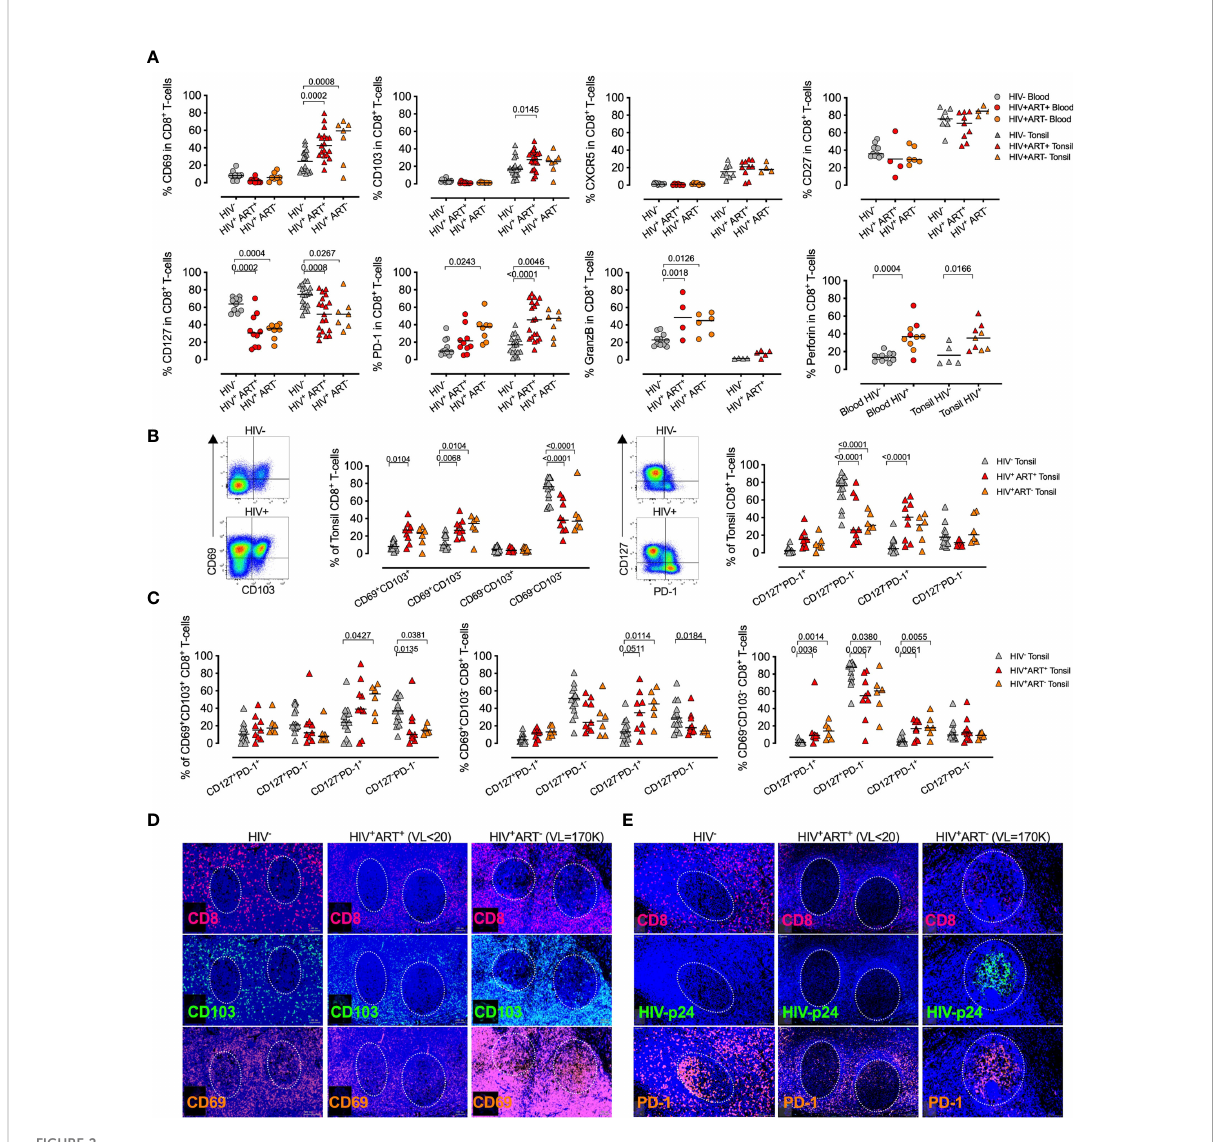
FIGURE 2 Treated HIV infection drives a tissue resident memory CD8 + T-cell phenotype with high PD-1 expression and distinct in situ tissue locations within HIV infected tonsils. (A) Percentage of blood ( n= 29, circles) and tonsil ( n= 44, triangles) CD8 + T-cells expressing CD69, CD103, CXCR5, CD27, CD127, PD-1, GZMB and perforin markers between HIV - (grey), HIV + ART + (red) and HIV + ART - (orange). P-values were calculated using ordinary one-way ANOVA with horizontal bars representing median values with the level of signi fi cance indicated with p-value. (B) Representative FACS plot of CD8 + T-cells from HIV - (grey) and HIV + ART + (red) HIV + ART - (orange) tonsils ( n= 29) for co-expression of CD69/CD103 and PD-1/CD127 with cumulative data shown with horizontal bars representing median values and p-values by Kruskal-wallis multiple comparisons. (C) CD127/PD-1 co- expression on indicated CD69/CD103 CD8+ T-cell subsets. (D) CD8, CD69, CD103 fl uorescence immunohistochemistry of whole tonsil sections zoomed in at individual GCs for three independent donors from HIV - (left), HIV + ART + (middle) and HIV + ART - (right) with individual markers shown and plasma viral load in brackets (above) and GCs indicated by dotted white circle. (E) Same as in C but for CD8, HIV-p24 and